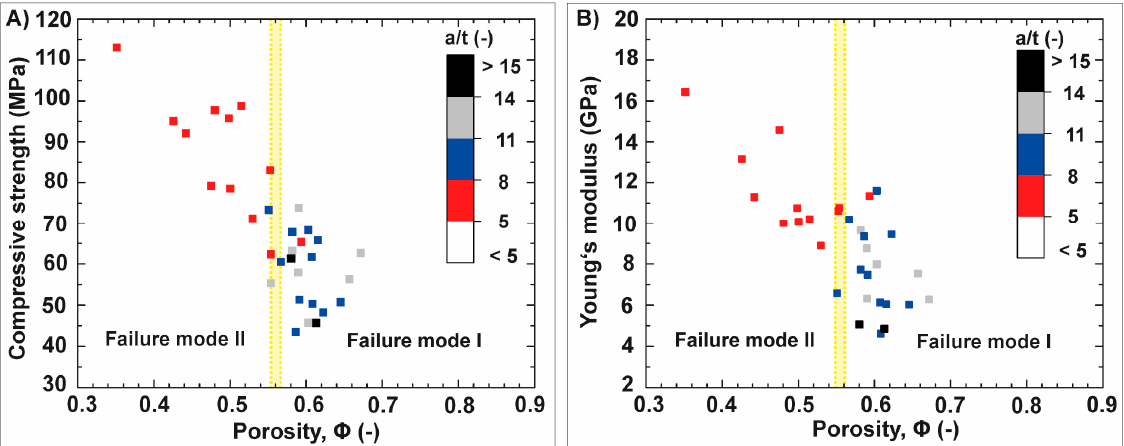
Figure 11. Plots in ( A , B ) show the maximum compressive strength and Young’s modulus of the spine segments of Phyllacanthus imperialis as a function of the porosity, Φ . The color bar indicates the structural factor of the spine segments, the a/t ratio. A change of the failure modes was observed at a porosity of approximately 55% being highlighted in the plots as light-yellow line.